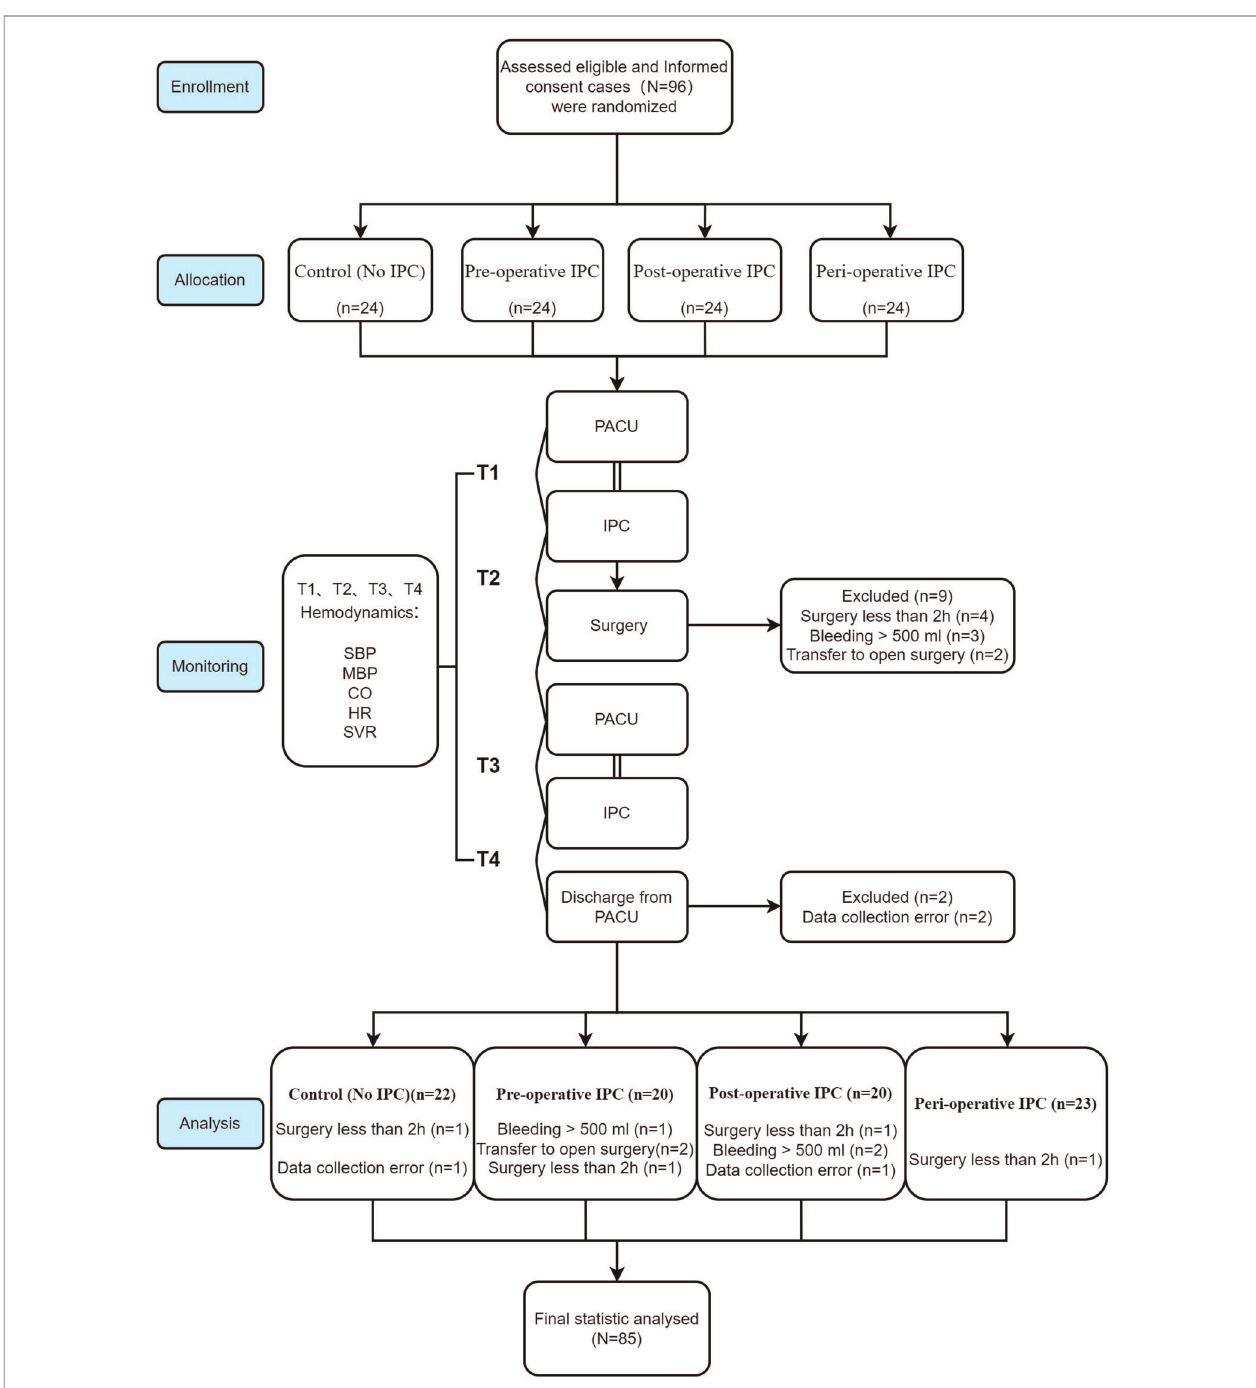
FIGURE 1 | Flow chart of patients enrollment, allocation, follow up and analysis in line with CONSORT